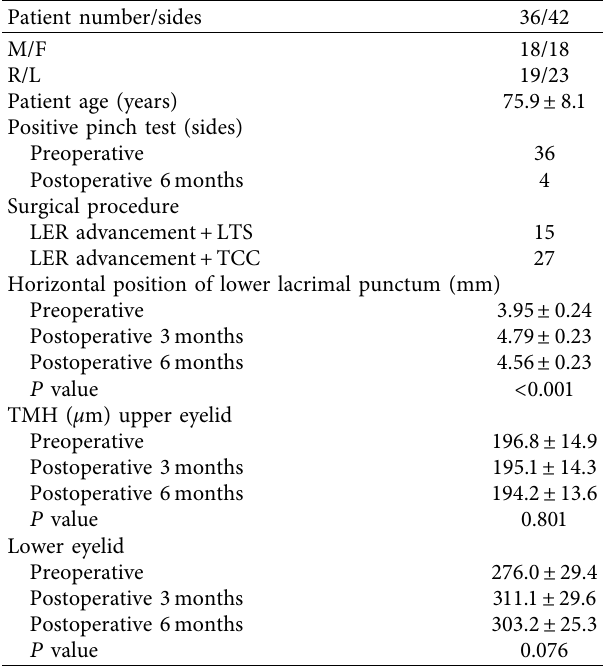
Table 1: Demographic data and results of measurements and statistical